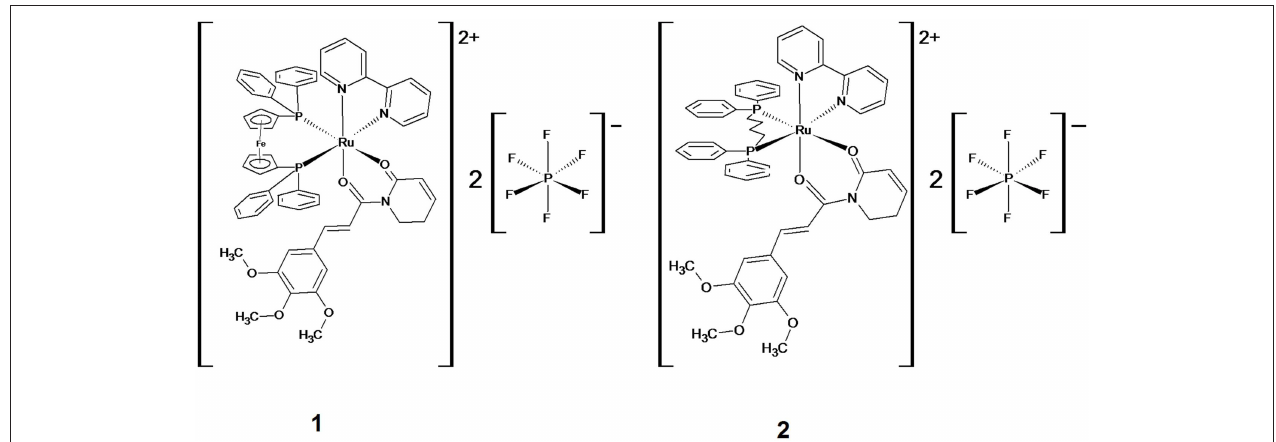
FIGURE 1 | Chemical structure of ruthenium complexes with piplartine, [Ru(piplartine)(dppf)(bipy)](PF 6 ) 2 ( 1 ) and [Ru(piplartine)(dppb)(bipy)](PF 6 ) 2 ( 2